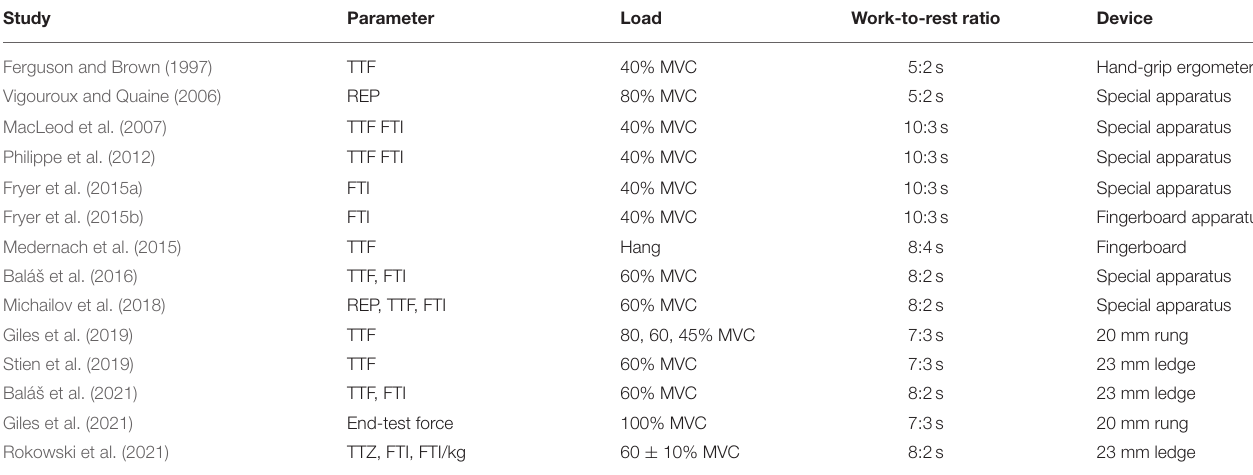
TABLE 2 | Overview of measurement methods of finger flexor muscle endurance using intermittent isometric contractions.